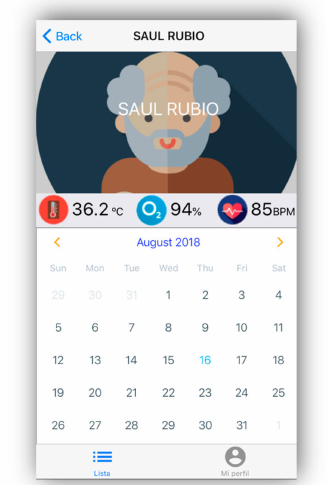
Figure 7. Real-time readings of the device’s sensors.